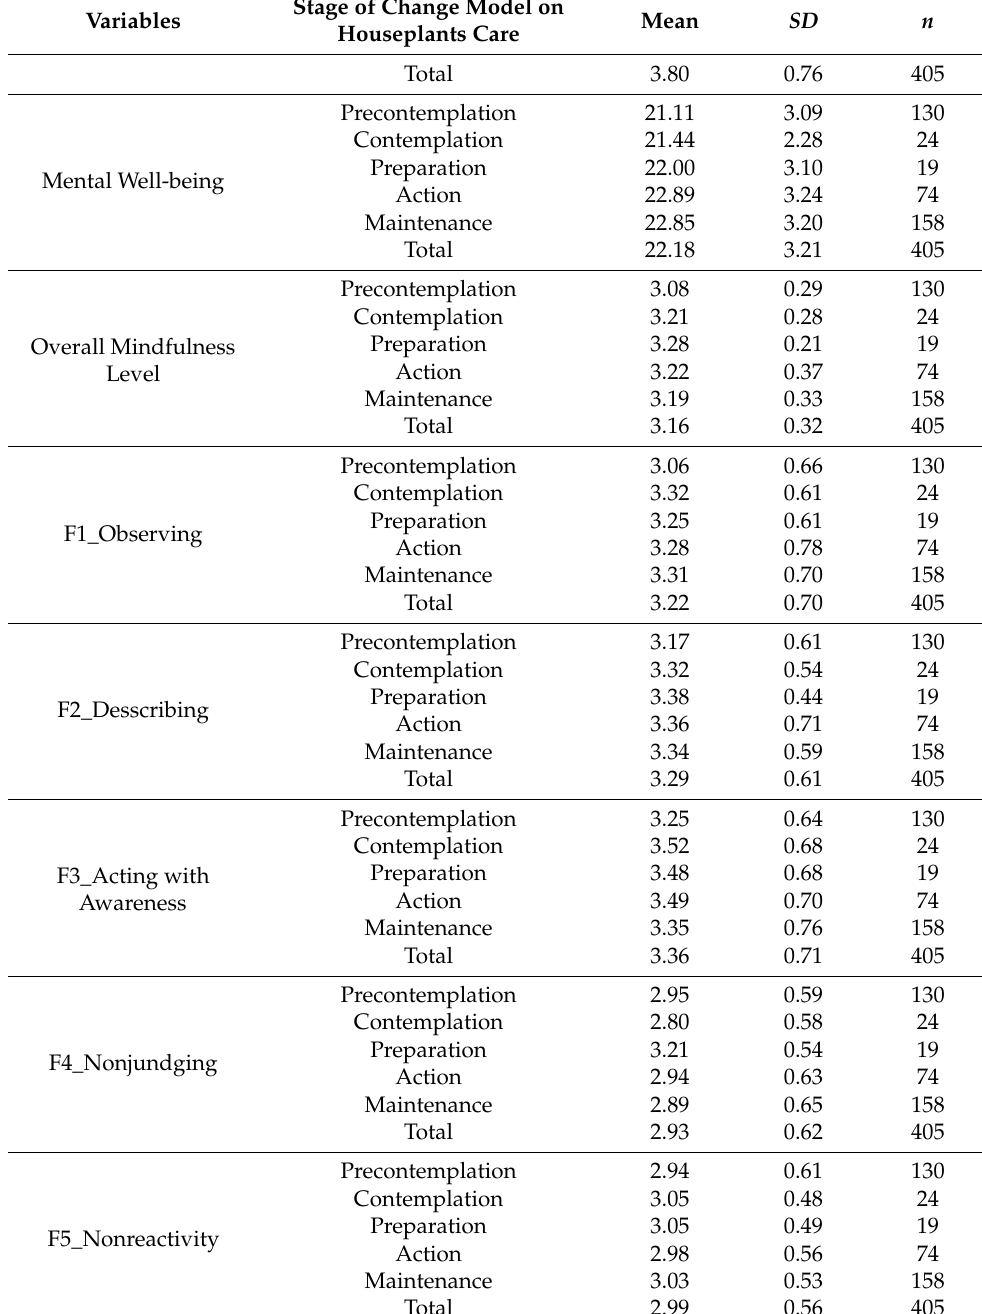
Table 2. Descriptive statistics of mental well-being and mindfulness levels on different Stage of Change